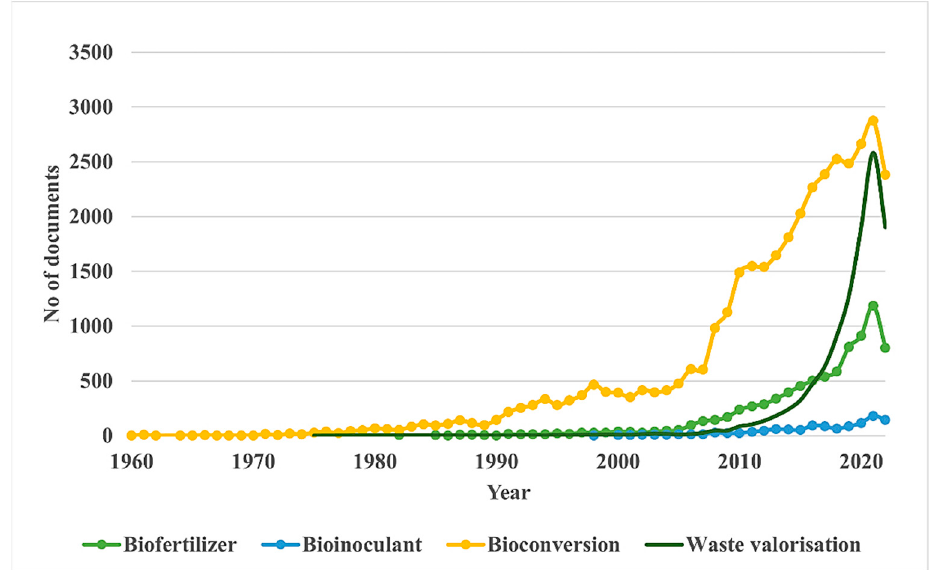
Figure 4. Trends in research publication using the keywords “waste valorisation”, “bioconversion” and “biofertilizer” over